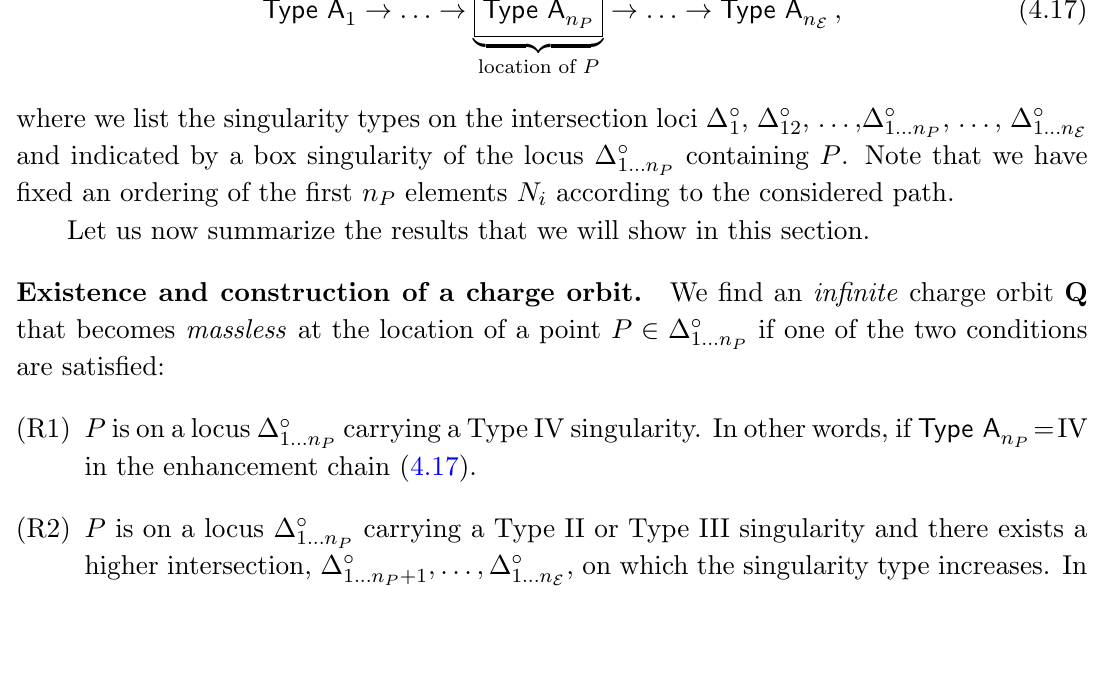
. Within 1 :::n P 1 :::n E